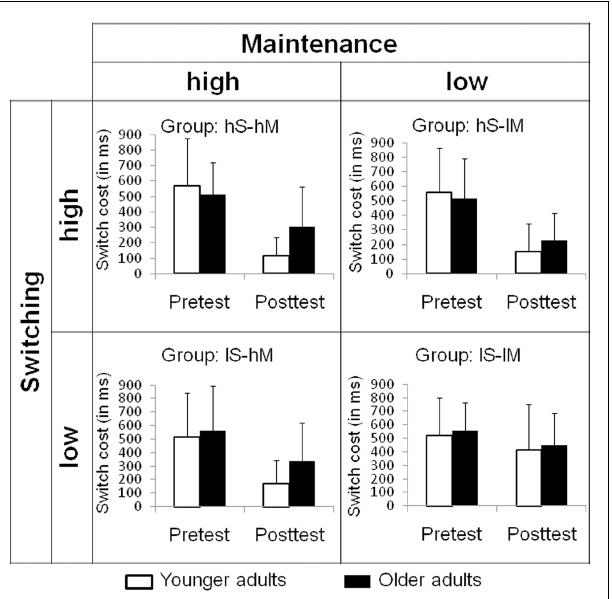
FIGURE 3 | Switch costs (ms) as a function of session, age group, and training group.